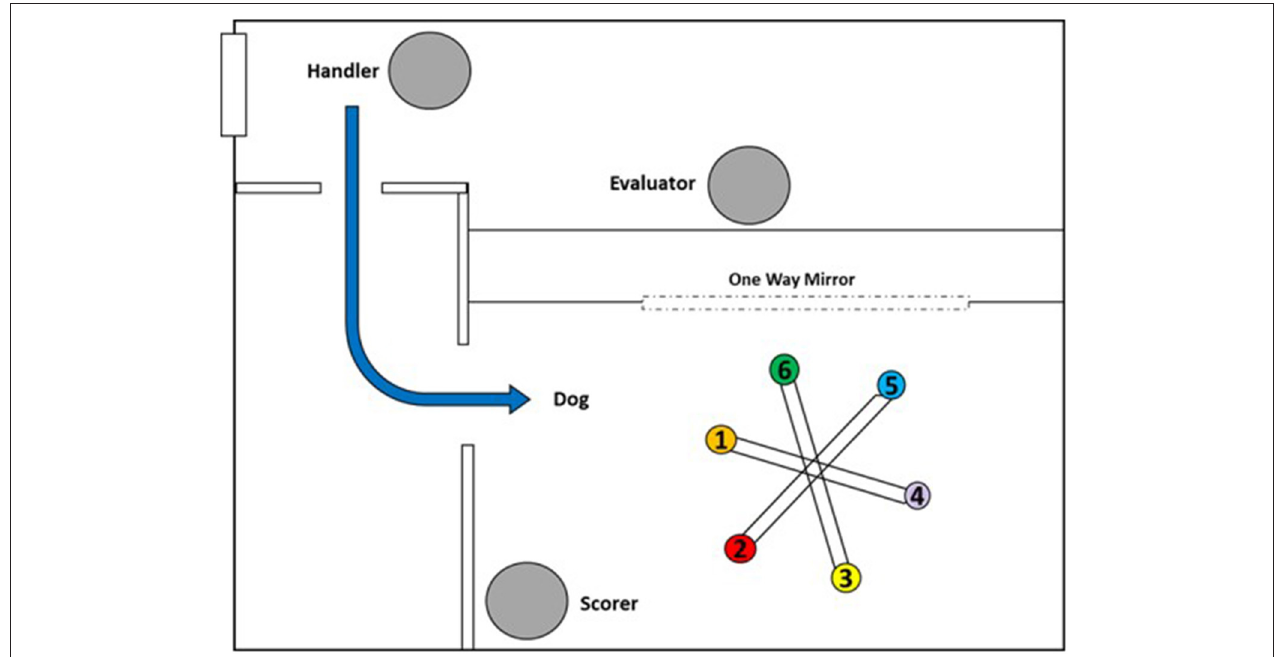
FIGURE 2 | Room layout for wheel testing. Scorer is unaware of trial set-up and blind to target placement or trial type and unable to see the moderator behind the one-way mirror. Dog is released from the handler to enter the wheel room off-leash and search independently.